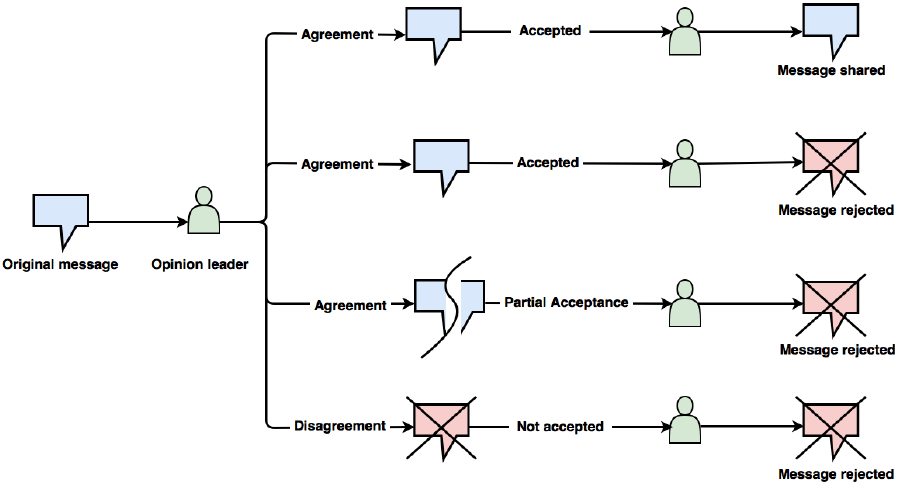
Figure 1. Illustration of user’s behaviour towards the incoming messages in a network. Table 1. Comparison of different variants of epidemic